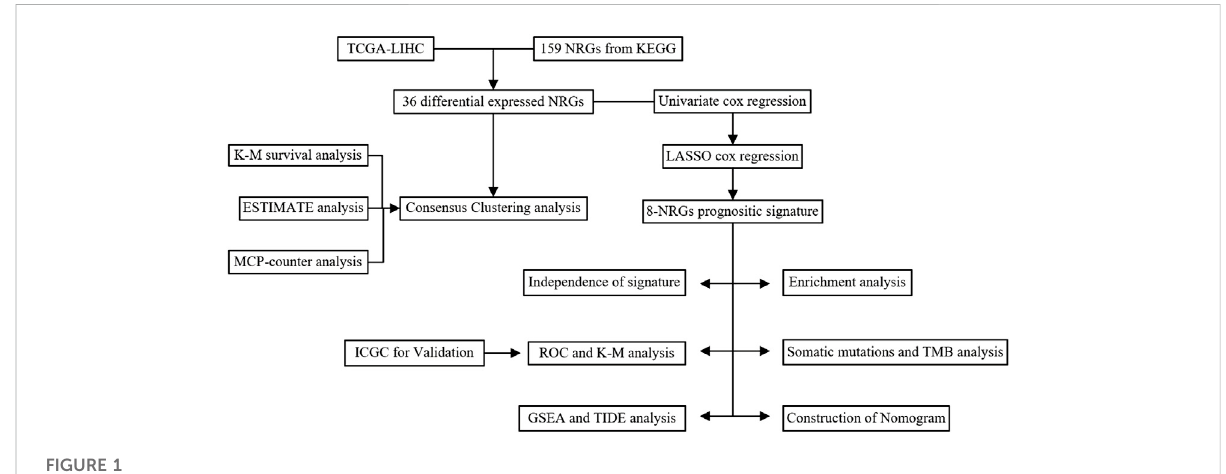
FIGURE 1 The fl owchart of this